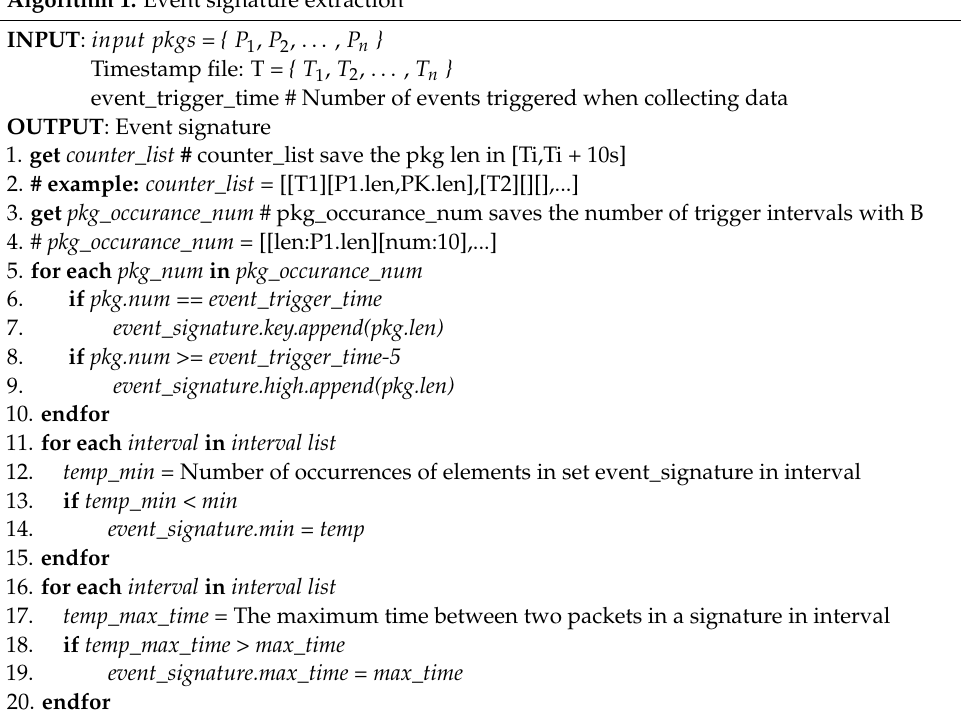
Algorithm 1. Event signature